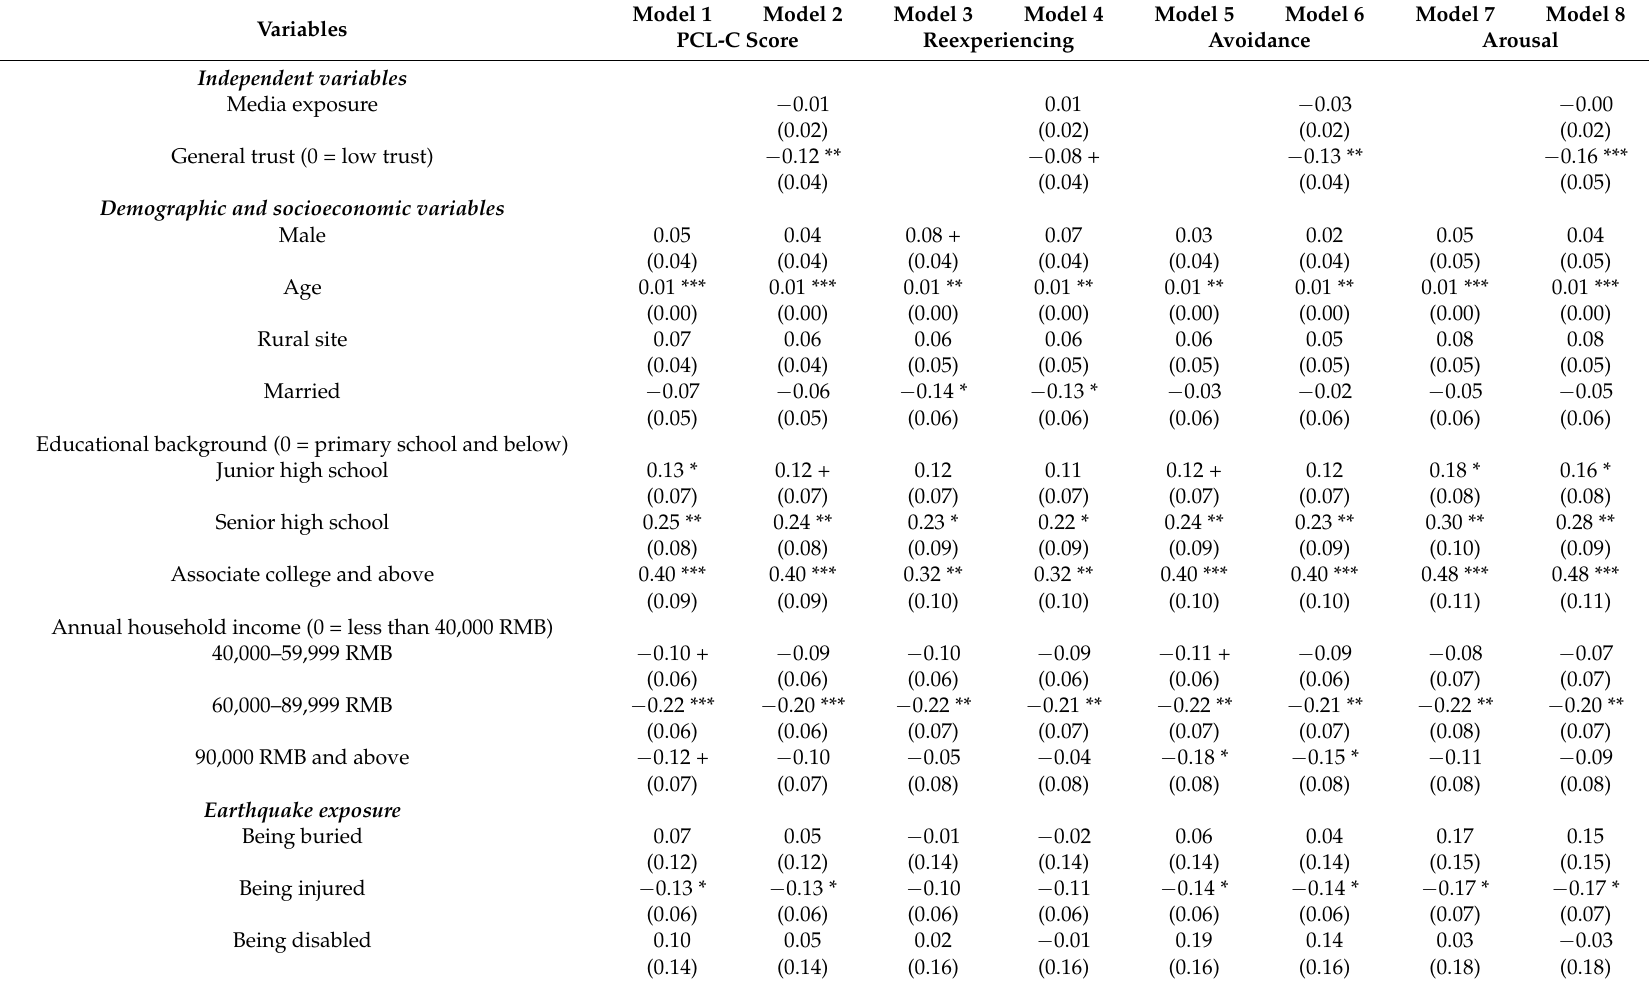
Table 2. Tobit model of predicting PTSD